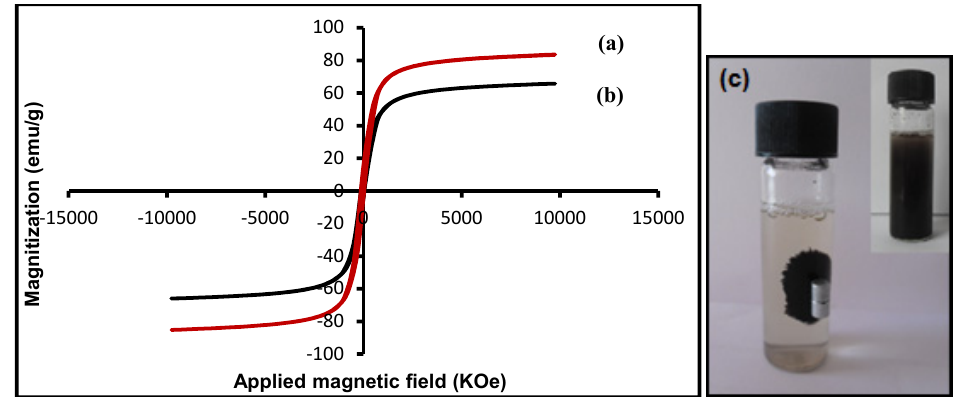
Figure 12. TGA/DTA curves of Fe